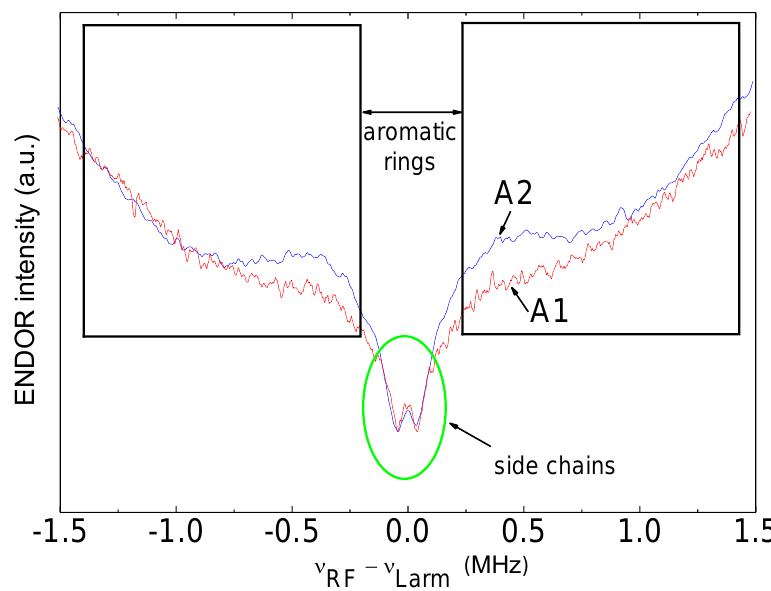
Figure 8. 1 H ENDOR spectra for A1 and A2 fractions.